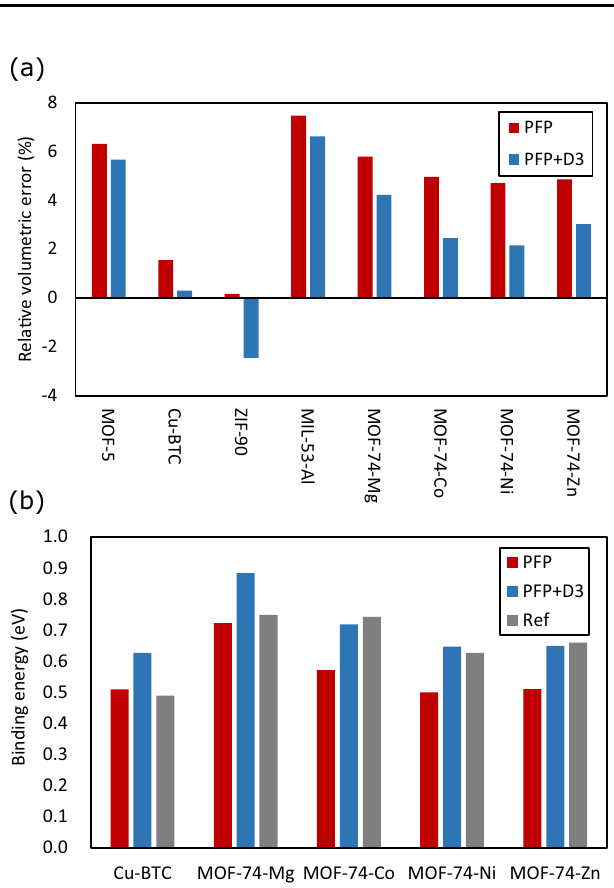
Fig. 2 Validations of MOF structures created by PFP. a Relative error between optimized unit cell and experimentally determined cell volumes. b Mean binding energies of H 2 O molecules in selected MOFs with open metal sites with PFP, PFP + D3, and reference values. All reference values are obtained from DFT calculations.